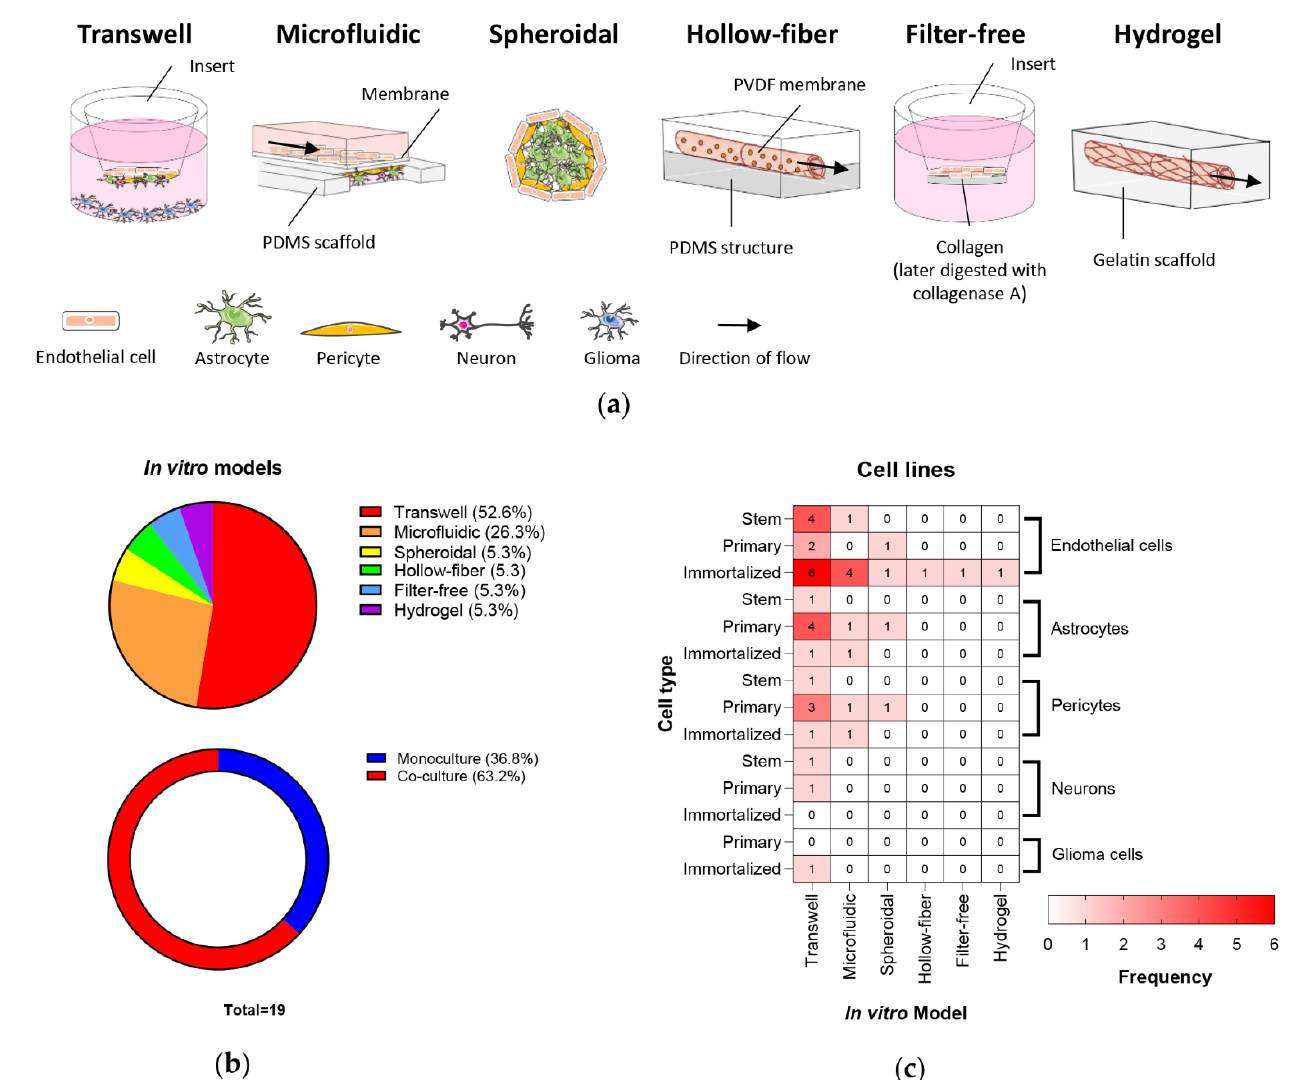
Figure 2. In vitro BBB/BBTB models. ( a ) Schematic representations of transwell, microfluidic, spheroidal, hollow-fiber, filter-free and hydrogel scaffold models. ( b ) Pie and donut chart of the articles employing each in vitro model and the division of EC monoculture and co-culture studies, respectively, and ( c ) a heat map of the utilization of stem, primary and immortalized EC, astrocyte, pericyte, neuron and glioma cell lines. Figure prepared using Servier Medical Art (https://smart.servier.com/ accessed: 3rd November 2020). PVDF, polyvinylidene fluoride; PDMS, polydimethylsiloxane.